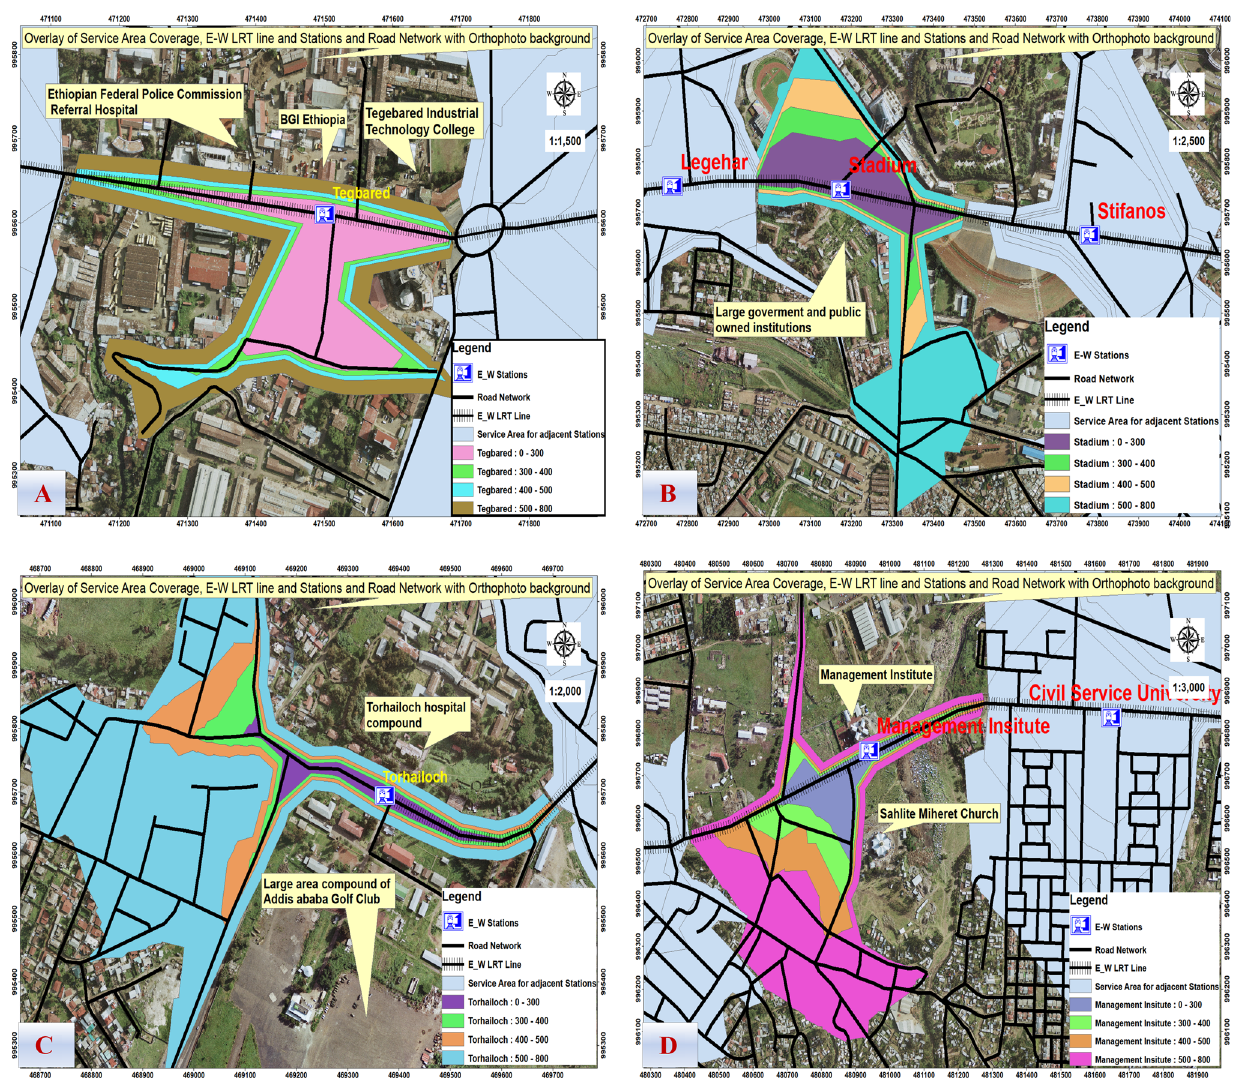
Fig. 5 Service areas of stations a Tegebared, b Stadium, c Torhailoch, d Management